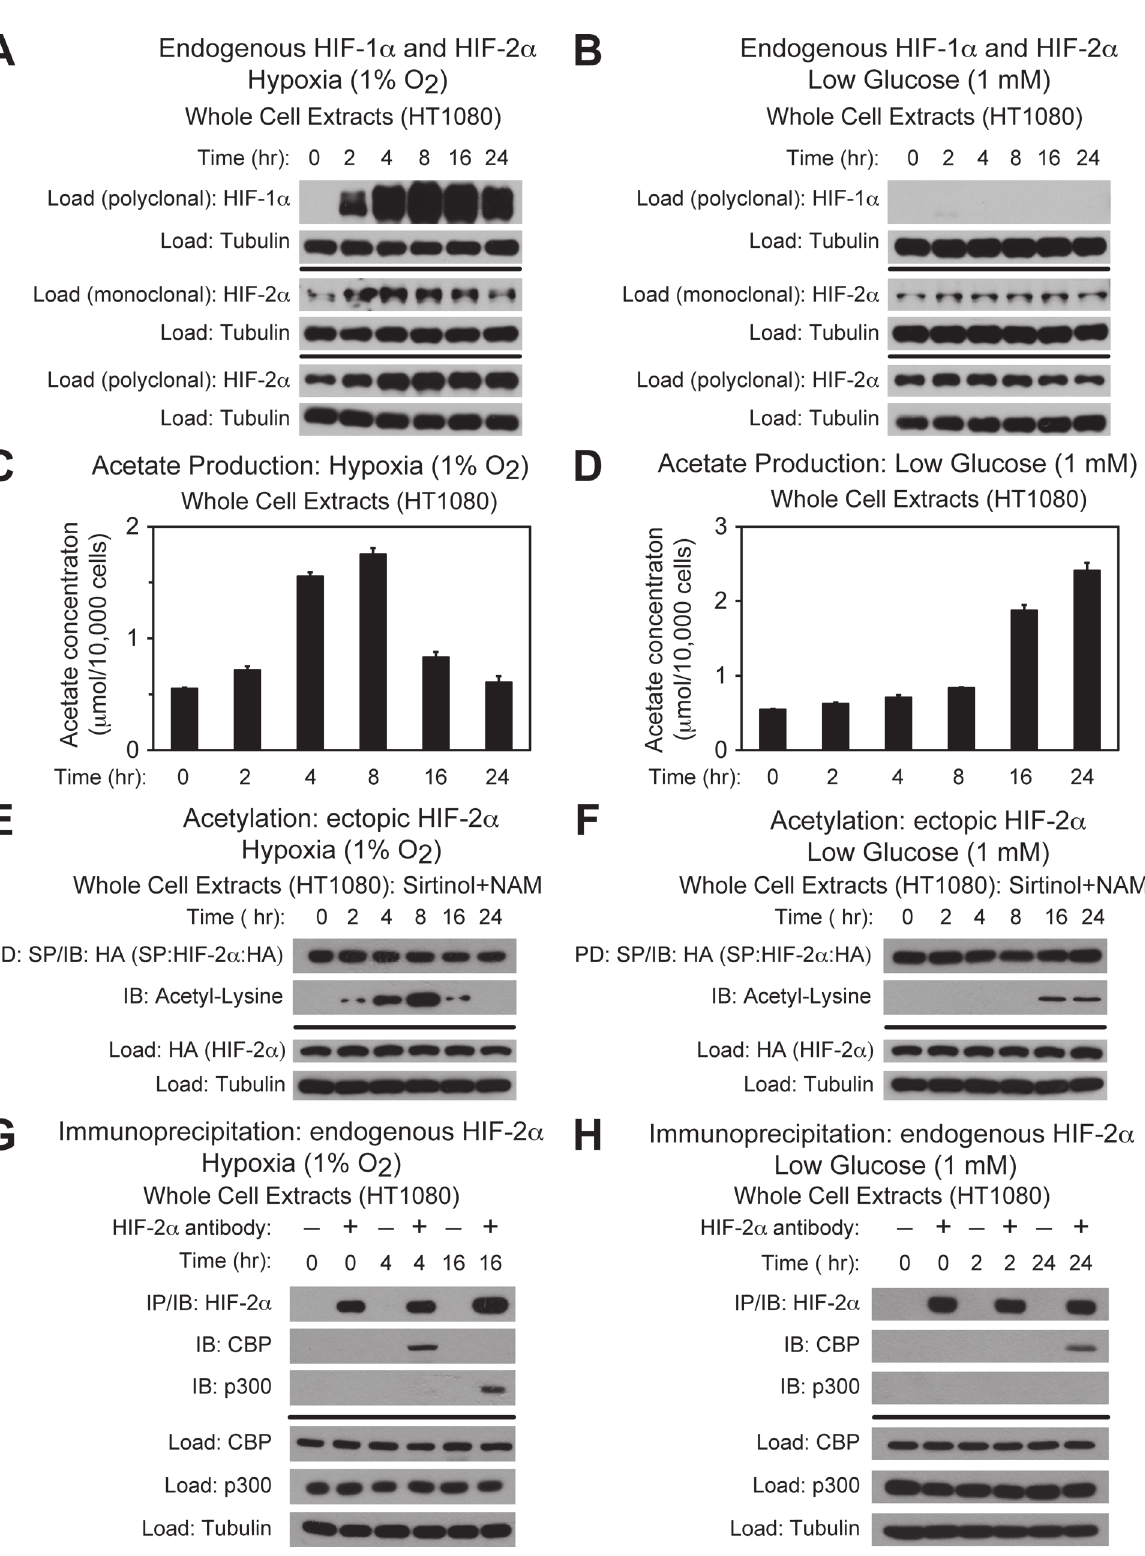
PLOS ONE | DOI:10.1371/journal.pone.0116515 February 17,